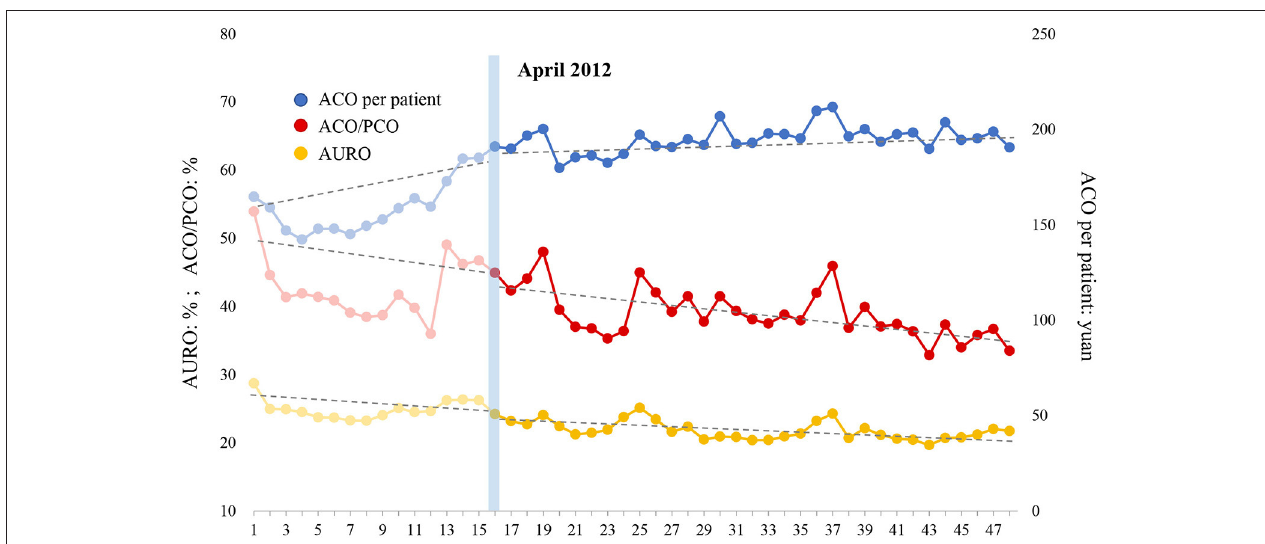
FIGURE 3 | Effect of intensified CSRA policy on three indicators representing antibiotic use of outpatient patient. AURO, antibiotic use rate of outpatients; ACO, antibiotic cost of outpatients; PCO, prescription cost of outpatients.